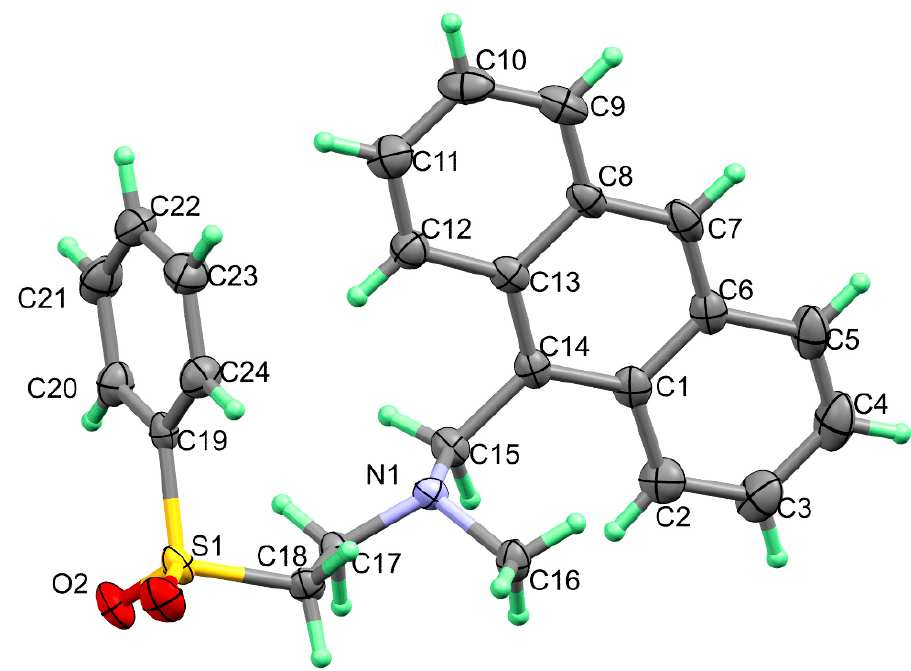
Figure 1. X-ray structure with thermal displacement ellipsoids plotted at 30% probability level for molecule 3 .